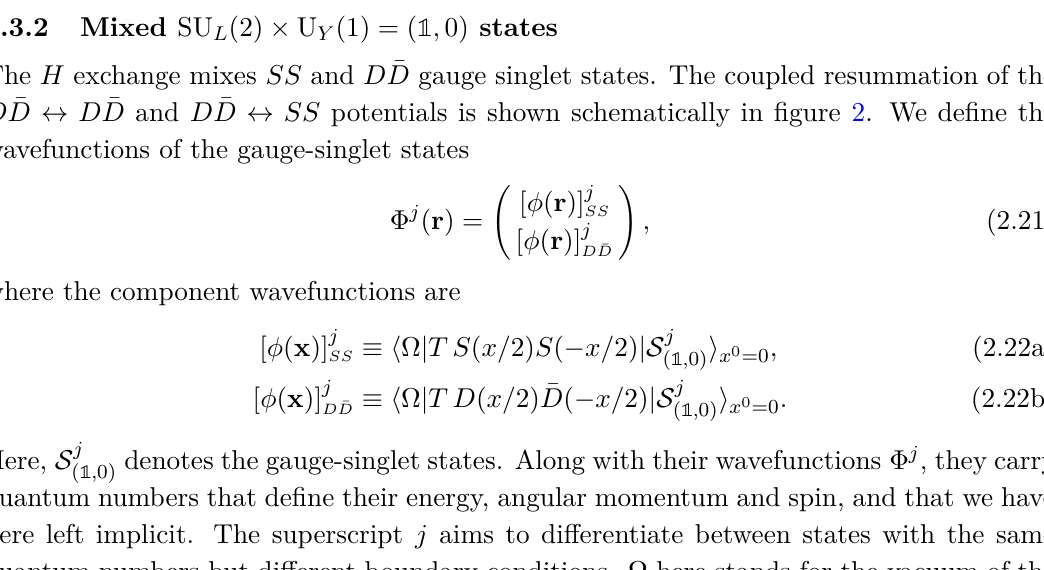
Figure 2 . The resummation of 2PI diagrams for the gauge-singlet states, SU Single and double lines correspond to S and D